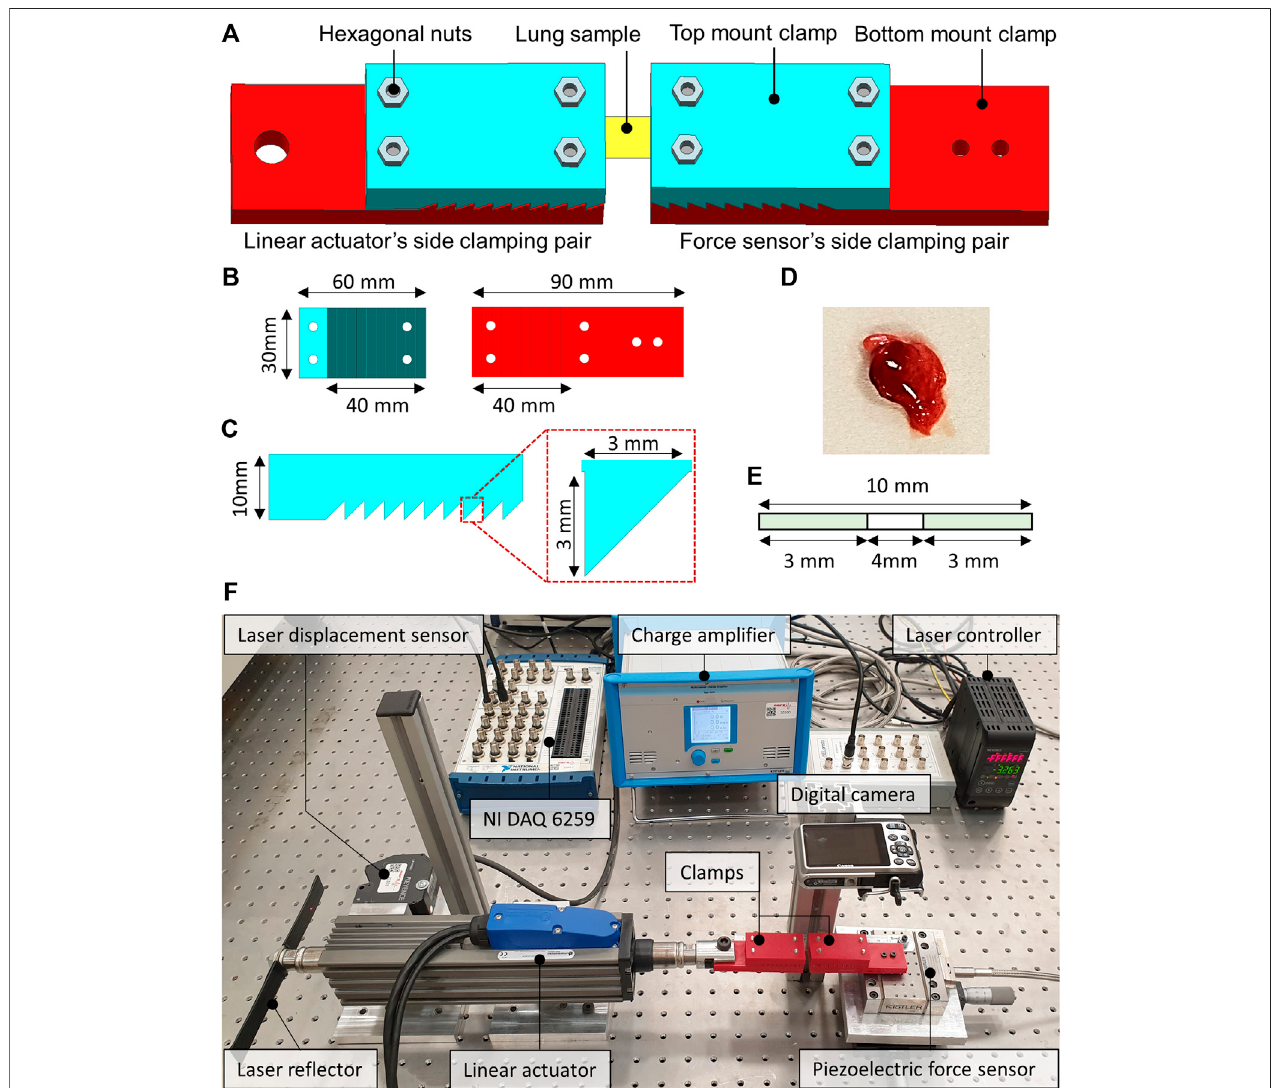
FIGURE 1| The computer-aided design (CAD) ofthe sample holding clamps and the dissected lung sample of therat. (A) The locking of the lung sample between theforcesensorsideandthelinearactuatorsideclamps. (B) CADmodelofthetopandbottommountoftheclamps. (C) Zoomed viewofthesaw-toothstructureonthe clamps along with the dimensions. (D) Dissected lung sample of the rat. (E) The schematics illustrate the dimensions of the studied lung sample. (F) The custom-built tensile testing experimental setup indicates the laser displacement sensor, the force sensor, the linear actuator, and the data acquisition system.